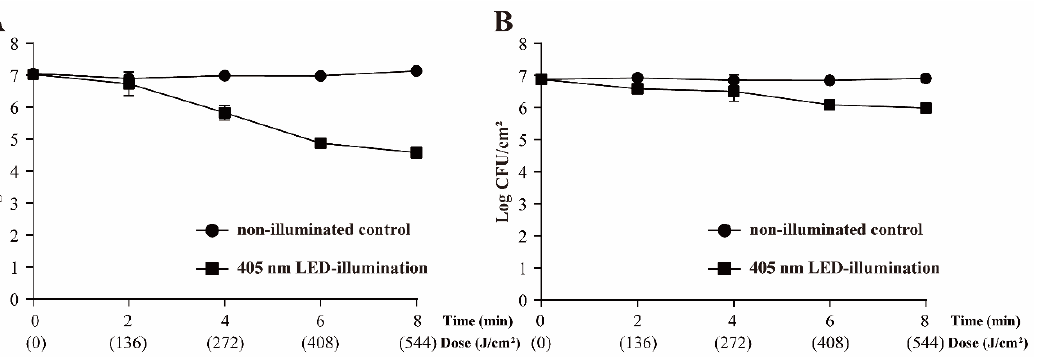
Figure 2. Effect of 405 nm LED-illumination on Salmonella Typhimurium in phosphate-buffered saline (PBS) ( A ) and on beef slices ( B ) at 4 °C.